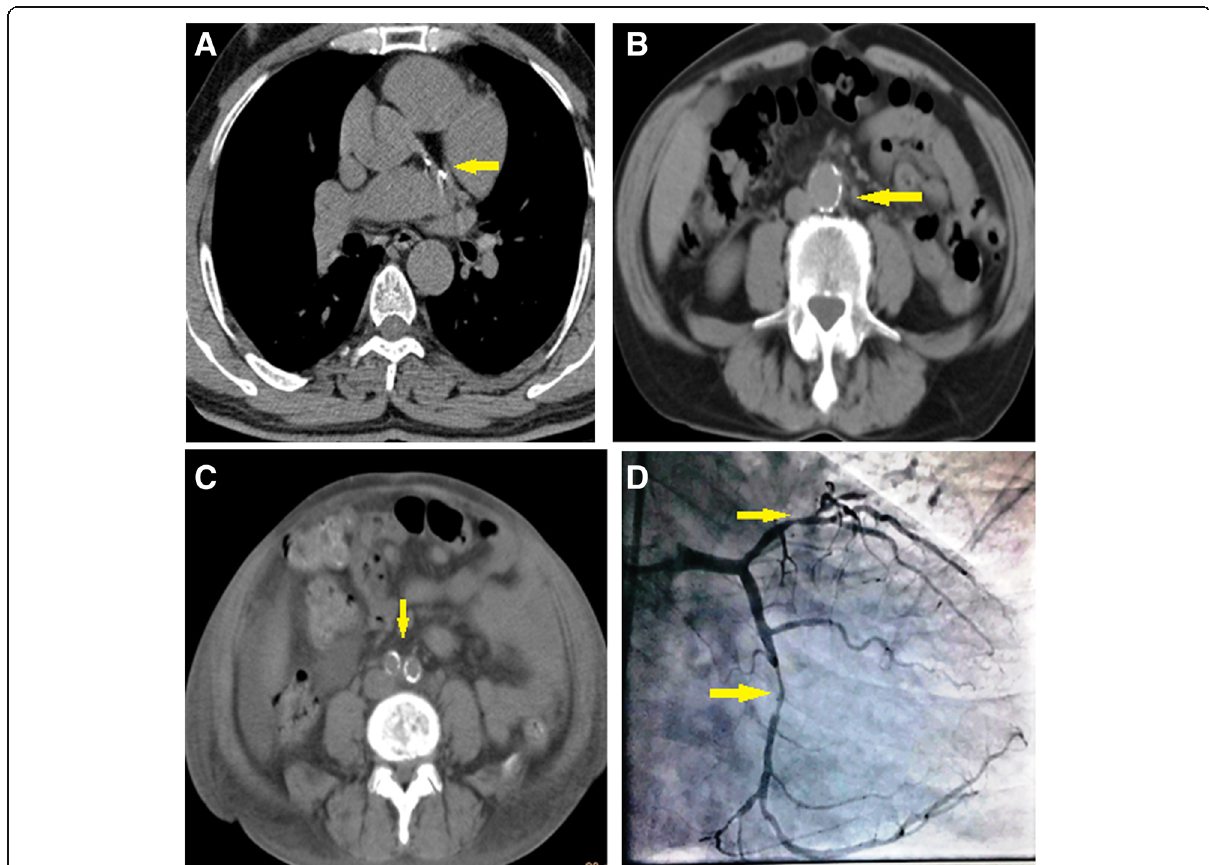
Fig. 3 Representative case showing a non-contrast ECG-gated MSCT examination of the coronary artery showing calcified athermanous plaques at the proximal segment of the LCX (arrow). The b and c images are non-contrast MSCT of the lower limb arterial system showing calcified athermanous plaques at the infra-renal segment of the abdominal aorta and at both common iliac arteries, respectively (arrows). d Conventional angiography of the coronary arteries showing significantly stenotic lesions at the proximal LAD and mid LAD segments (arrows)